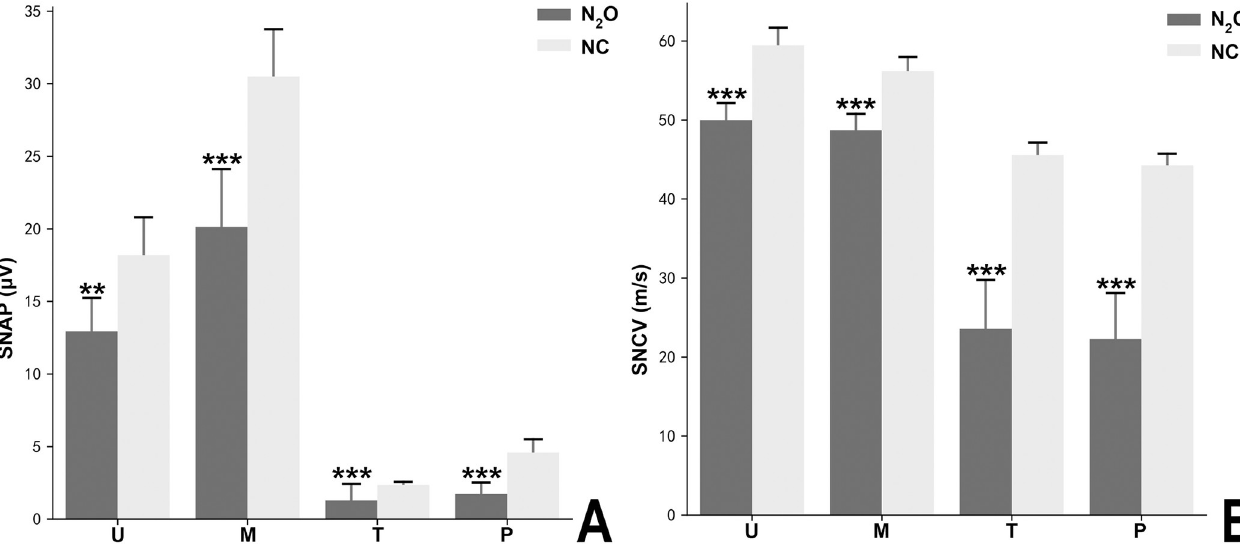
Fig 3. Sensory nerve conduction study results in the normal control (NC) and N 2 O-induced neuropathy groups. (A) The sensory nerve action potential amplitude and (B) sensory conduction velocity of each sensory nerve for the NC (N = 20, gray bar) and N 2 O-induced neuropathy groups (N = 18, black bar). Data are presented as mean ± standard error of the mean. Significant difference is indicated by ��� p < 0.001, �� p < 0.005, � P < 0.01 using Mann-Whitney U test. M, median nerve; U, ulnar nerve; P, peroneal nerve; T, tibial nerve.